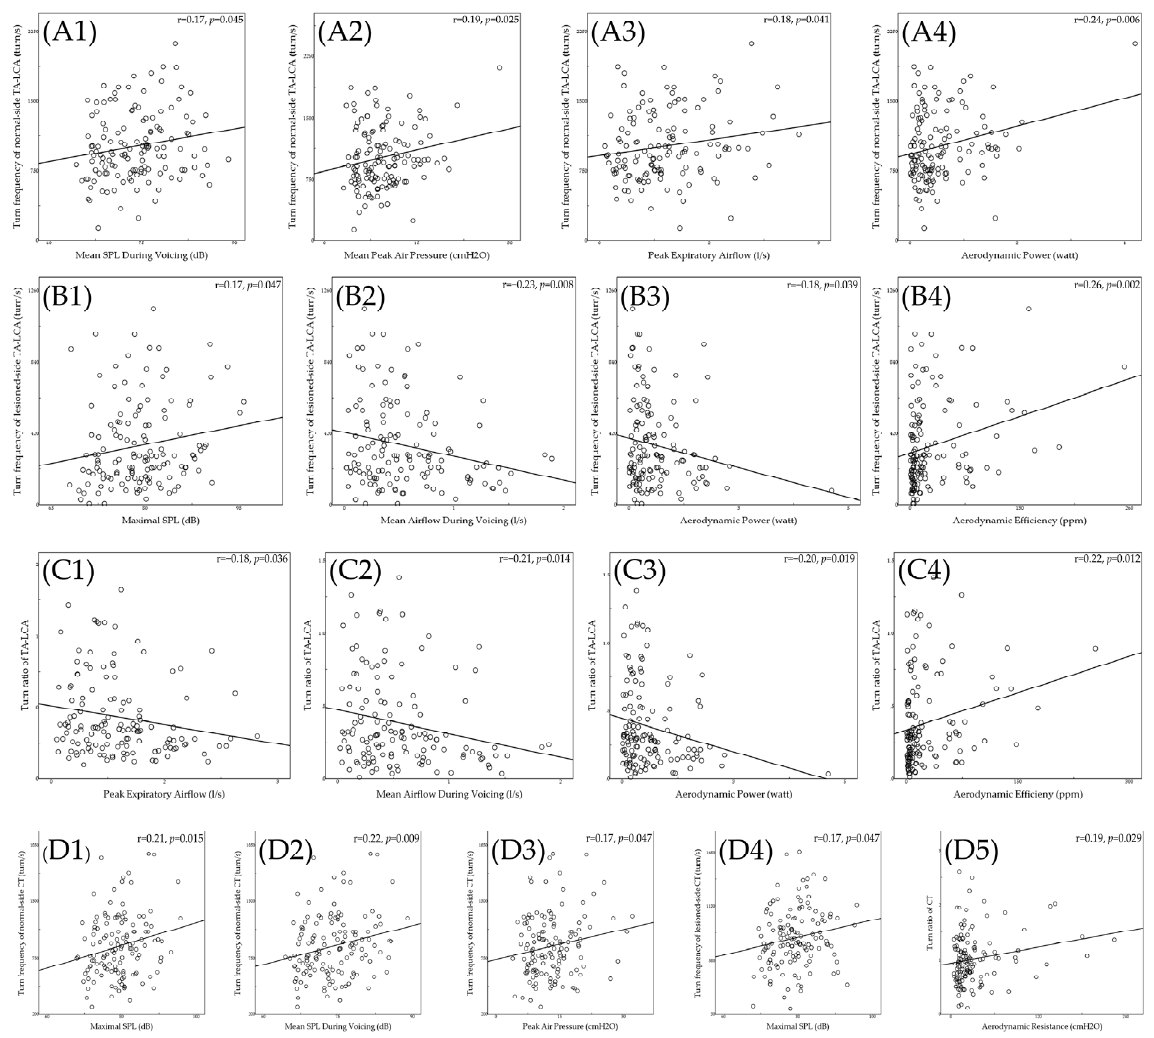
Figure 5. Scatter plots showing the relationship between parameters of quantitative LEMG and aerodynamics. Peak turn frequency of the normal-side TA-LCA muscle complex showed significant positive correlations with ( A1 ) mean SPL during voicing (r = 0.17; p = 0.045), ( A2 ) mean peak air pressure (r = 0.19; p = 0.025), ( A3 ) peak expiratory airflow (r = 0.18; p = 0.041), and ( A4 ) aerodynamic power (r = 0.24; p = 0.006). Peak turn frequency of the lesioned-side TA-LCA muscle complex showed significant positive correlations with ( B1 ) maximal SPL (r = 0.17; p = 0.047) and ( B4 ) aerodynamic efficiency (r = 0.26; p = 0.002) but significant negative correlations with ( B2 ) mean airflow during voicing (r = − 0.23; p = 0.008) and ( B3 ) aerodynamic power (r = − 0.18; p = 0.039). The turn ratio of TA-LCA muscle complexes showed significant negative correlations with ( C1 ) peak expiratory airflow (r = − 0.18; p = 0.036), ( C2 ) mean airflow during voicing (r = − 0.21; p = 0.014), and ( C3 ) aerodynamic power (r = − 0.20; p = 0.019) but significant positive correlations with ( C4 ) aerodynamic efficiency (r = 0.22; p = 0.012). The peak turn frequency of the normal-side CT showed significant positive correlations with ( D1 ) maximal SPL (r = 0.21; p = 0.015), ( D2 ) mean SPL during voicing (r = 0.22; p = 0.009), and ( D3 ) peak air pressure (r = 0.17; p = 0.047). The peak turn frequency of the lesioned-side CT showed a significant positive correlation with ( D4 ) maximal SPL (r = 0.17; p = 0.047). The turn ratio of CT muscles showed a significant positive correlation with ( D5 ) aerodynamic resistance (r = 0.19; p = 0.029). TA-LCA, thyroarytenoid–lateral cricoarytenoid; CT, cricothyroid; SPL, sound-pressure